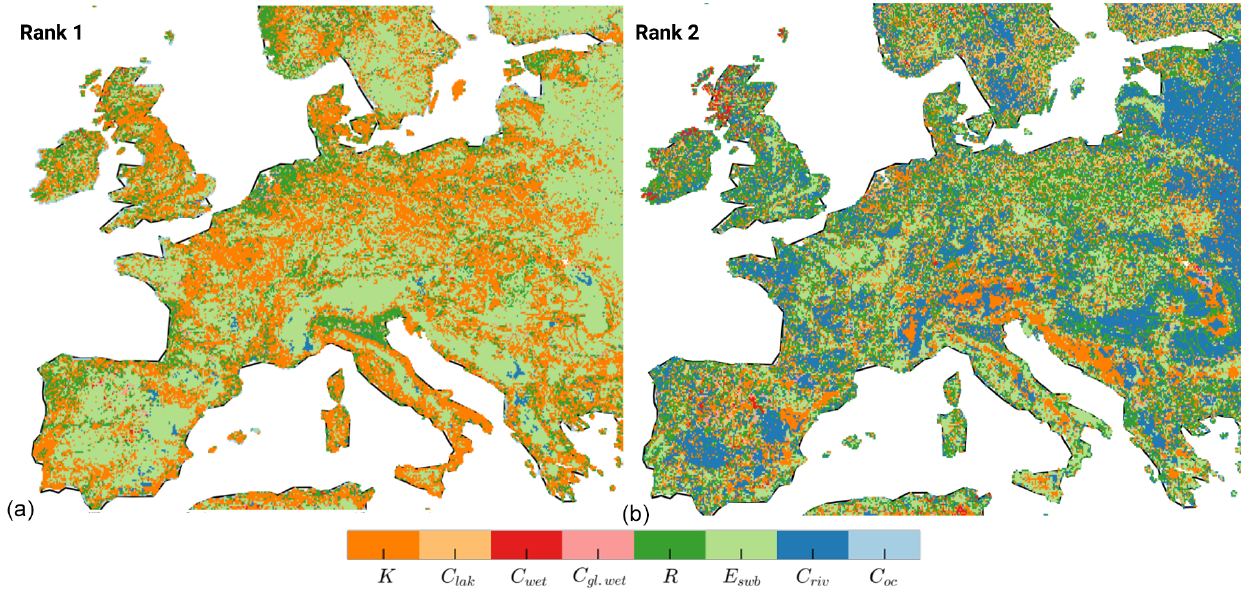
Figure 8. Enlarged view of Europe of Fig. 7. Ranking of µ ∗ of h ( a : rank 1, b : rank